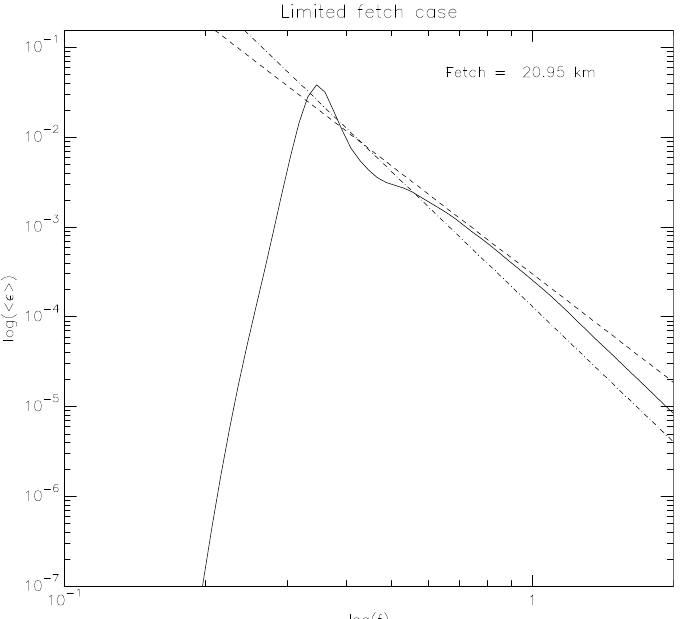
(cid:82) 2 π ε ( ω , θ ) d θ as 2 π 0